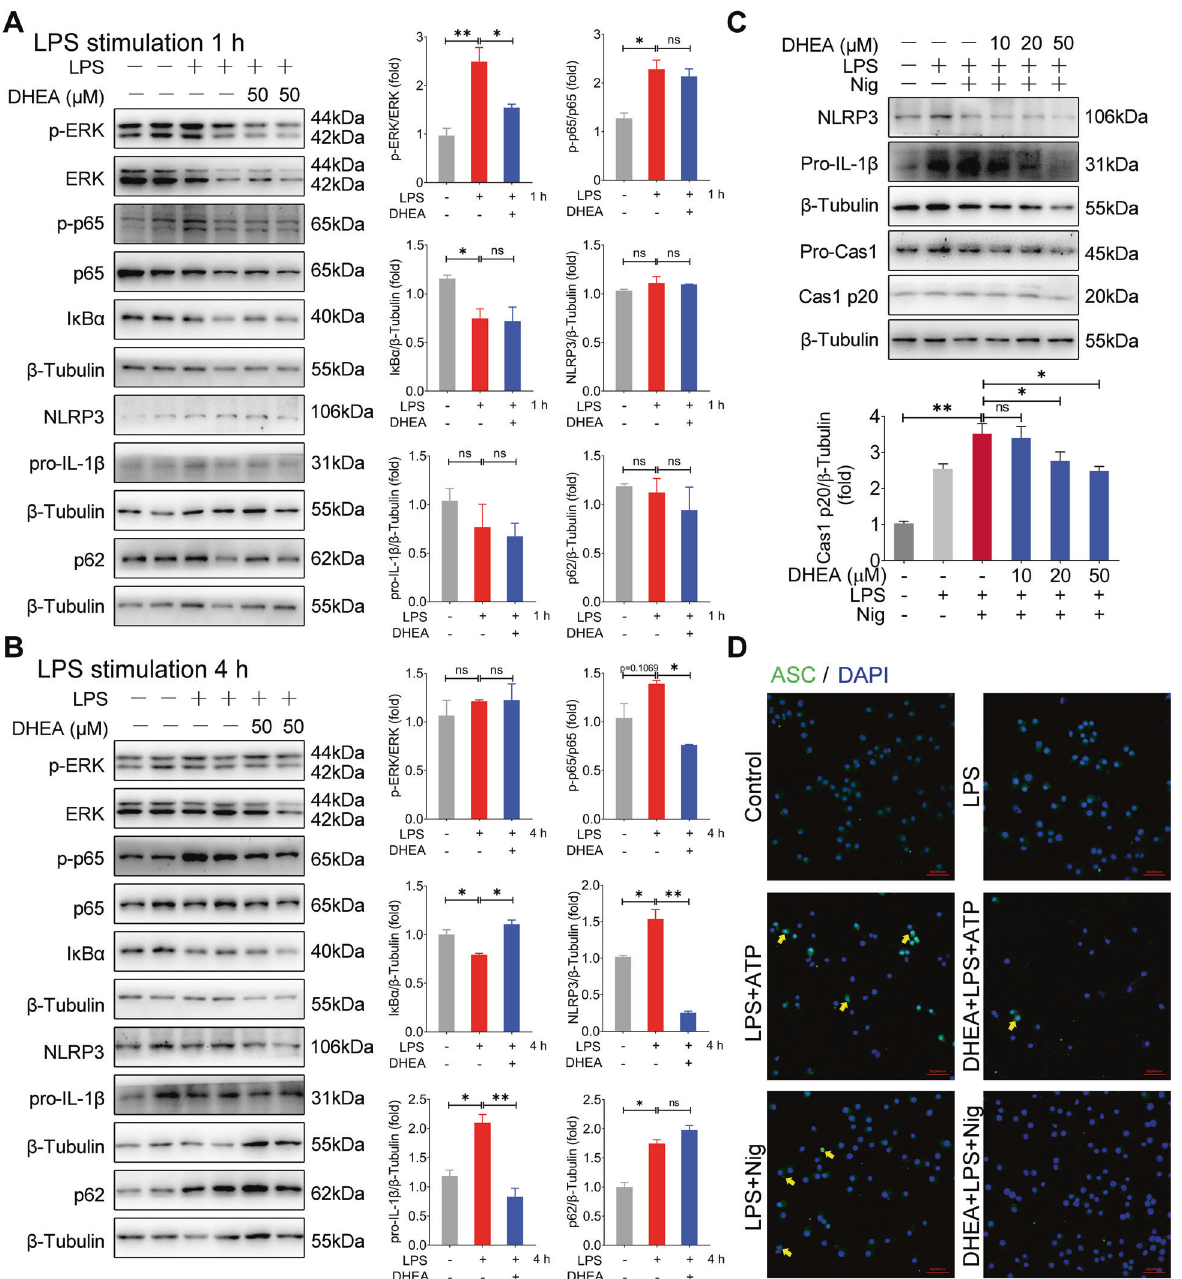
pro-IL-1 β , and p62 protein expression levels were measured by western blotting and quanti fi ed by Image J software. C J774A.1 cells were pre- treated with different doses of DHEA (0, 10, 20, 50 μ M) for 1 h and primed with 100 ng/mL LPS for 4 h; then stimulated with NLRP3 activators * P < 0.05, ** P < 0.01, compared with the respective